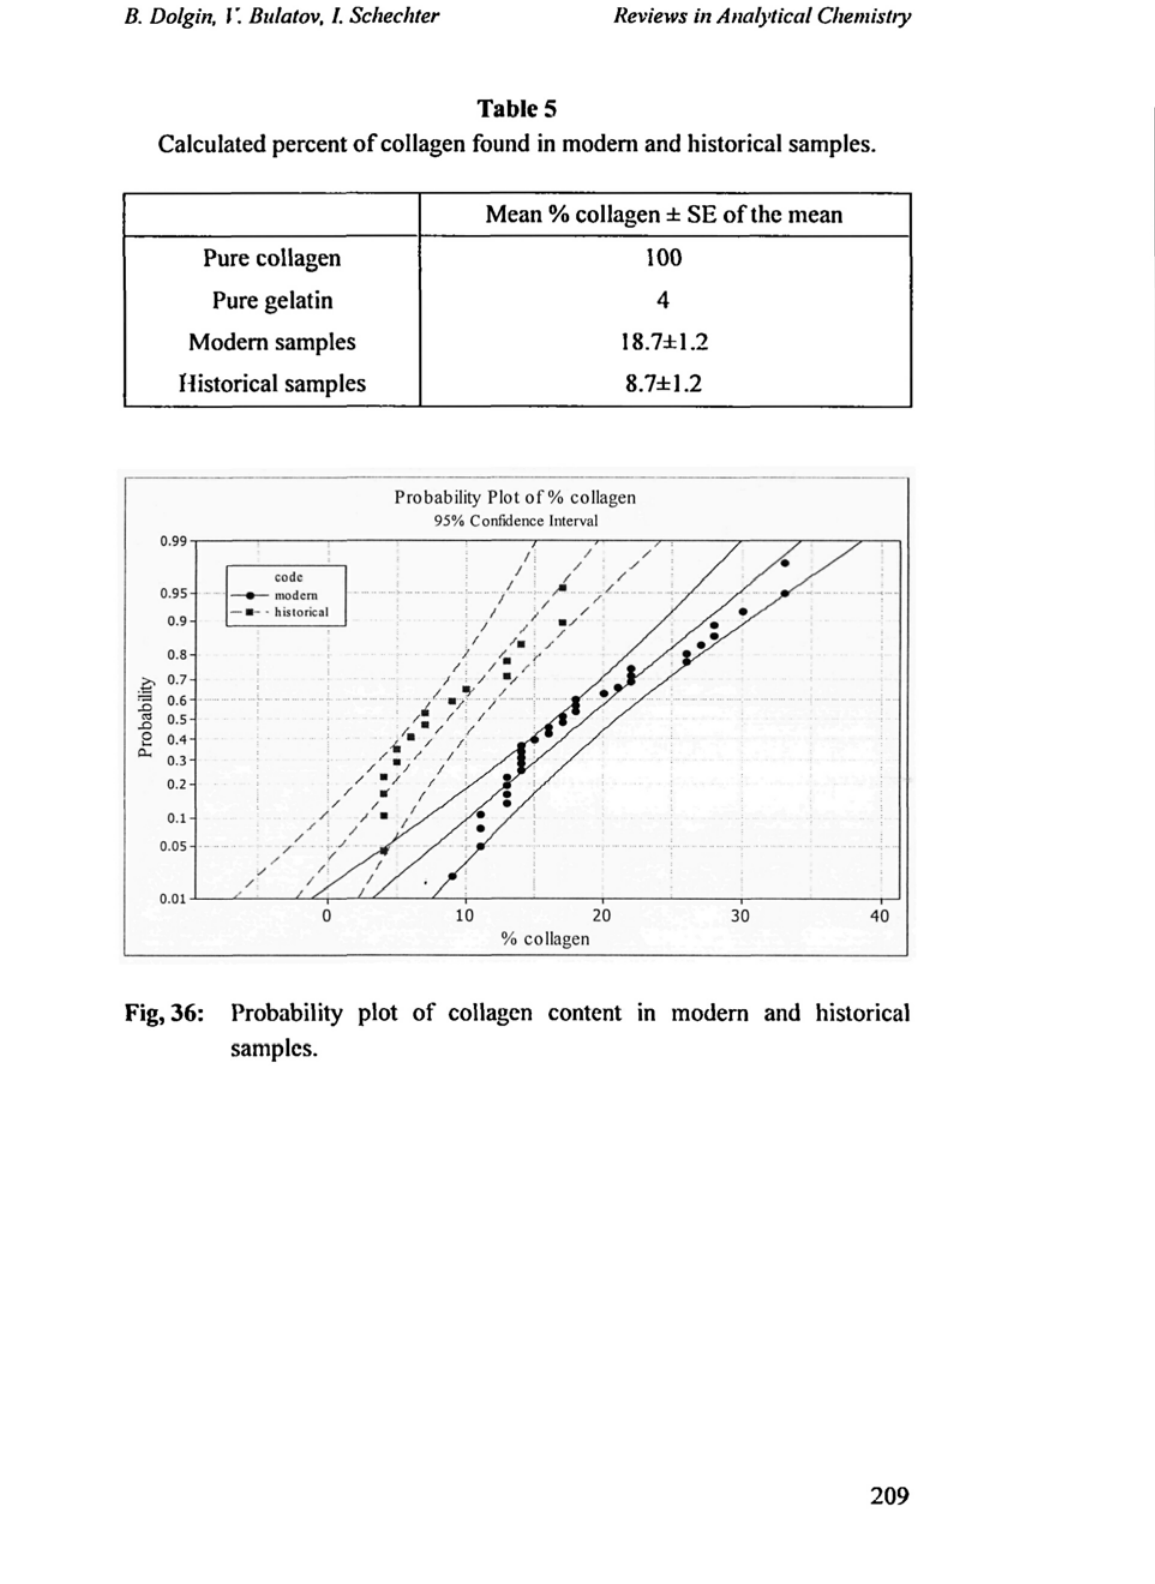
Probability plot of collagen content in modern and historical